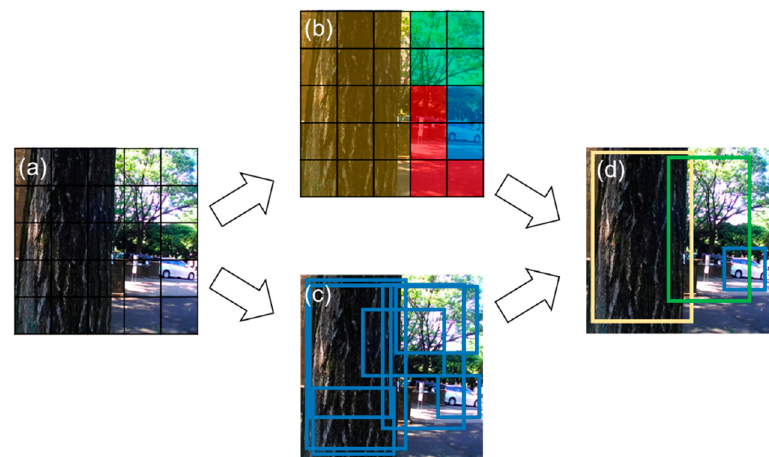
Figure 1. Overview of the YOLO detector. Input images were divided into cells of S by S ( a ). In each cell, the class probability ( b ) and the information related to the location, size, and confidence score ( c ) were estimated. By considering the information in ( b ) and ( c ), the final object detection was done ( d ). We referred to and modified the figure of Redmon et al. [31] for this image.